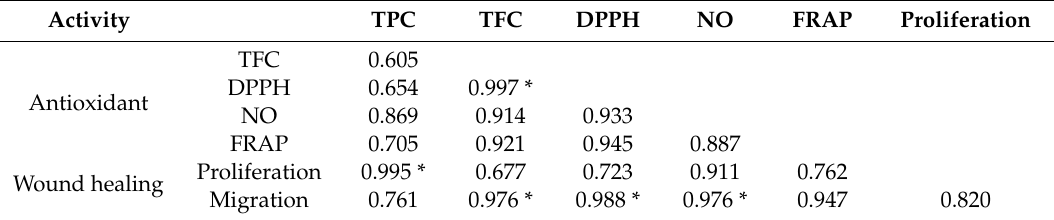
Table 3. Pearson’s coe ffi cient of antioxidant and wound healing activities of di ff erent OPL